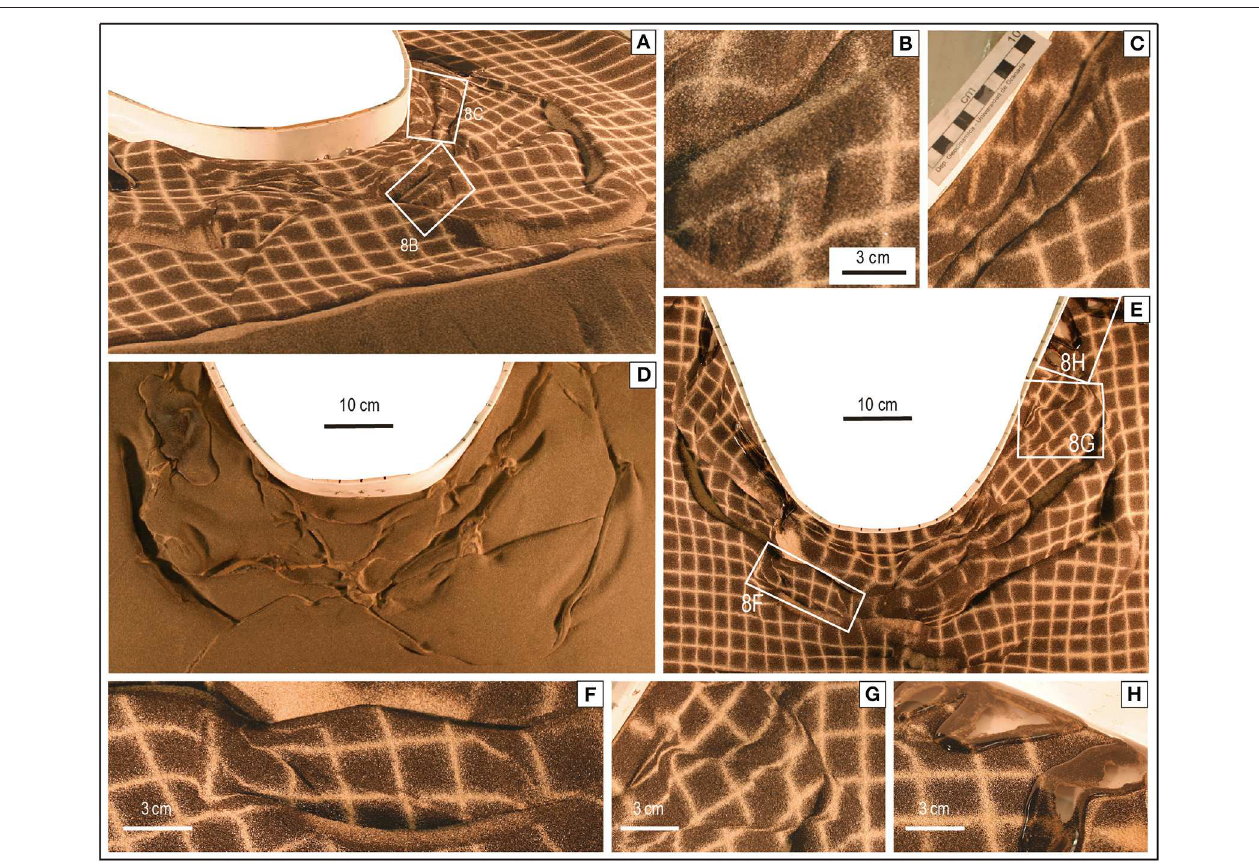
FIGURE 8 | Photographs of Models 4. (A) Oblique photograph of Model 4-2 at its final stage. (B) Millimetrical-spaced normal faults (localized on A ). (C) Transpressive bands at the arc limb (localized on A ). (D) Silicone topography of Model 4-2 once the sand is removed at the final stage. (E) Zenithal view of Model 4-1 at the completion of the experiment. (F) Millimetrical-spaced normal faults (localized on E ). (G) Conjugate strike-slip fault systems (localized on E ). (H) Silicone outcropping on the model surface (localized on E